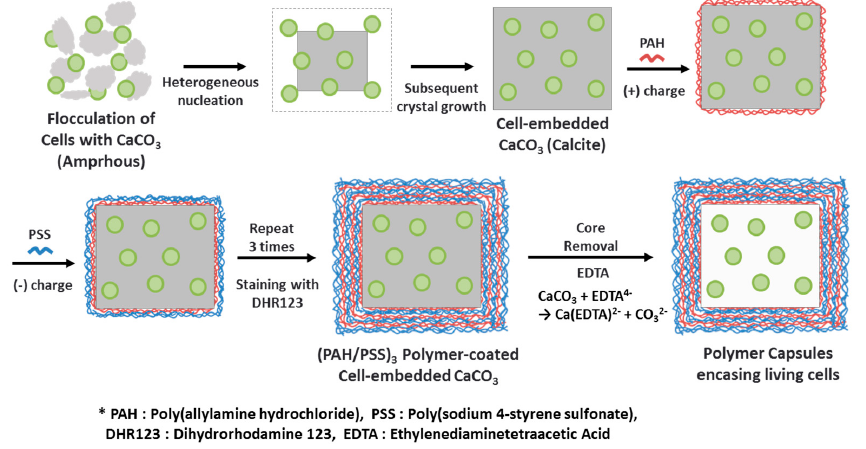
Figure 1. Illustrative scheme of the preparation of polymer capsules encasing living microalgal cells via CaCO 3 mineralization and a layer-by-layer (LbL) polyelectrolyte coating followed by CaCO 3 demineralization.